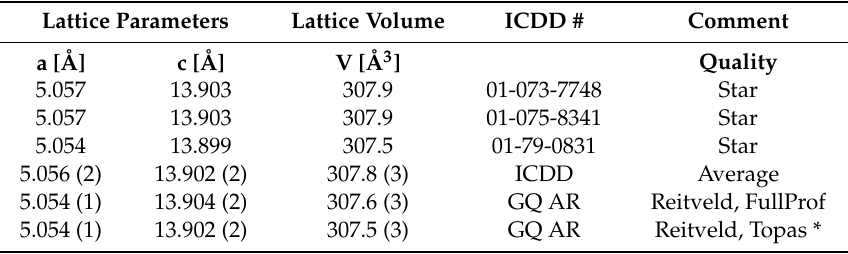
Table 1. RT lattice parameter of MgTiO 3.